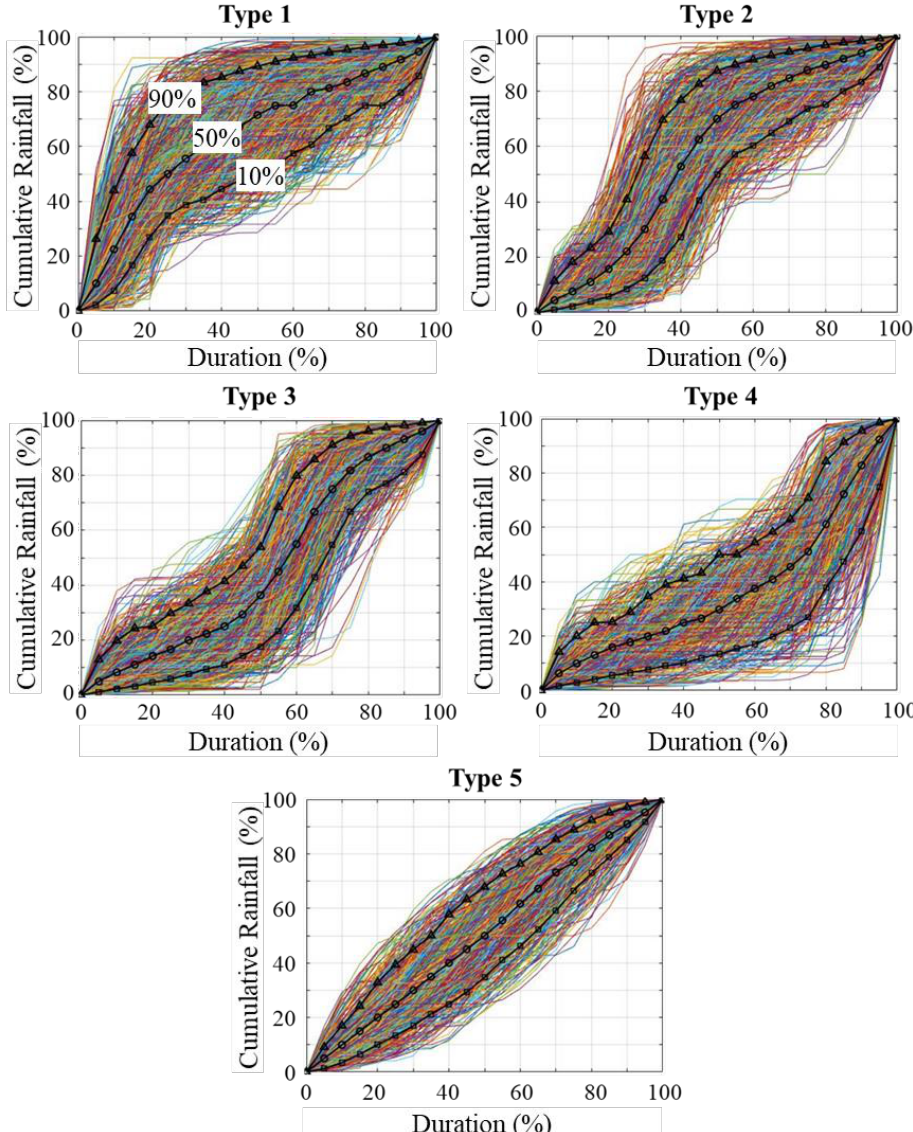
Figure 7. Summer rainfall events categorized using the modified Huff method.